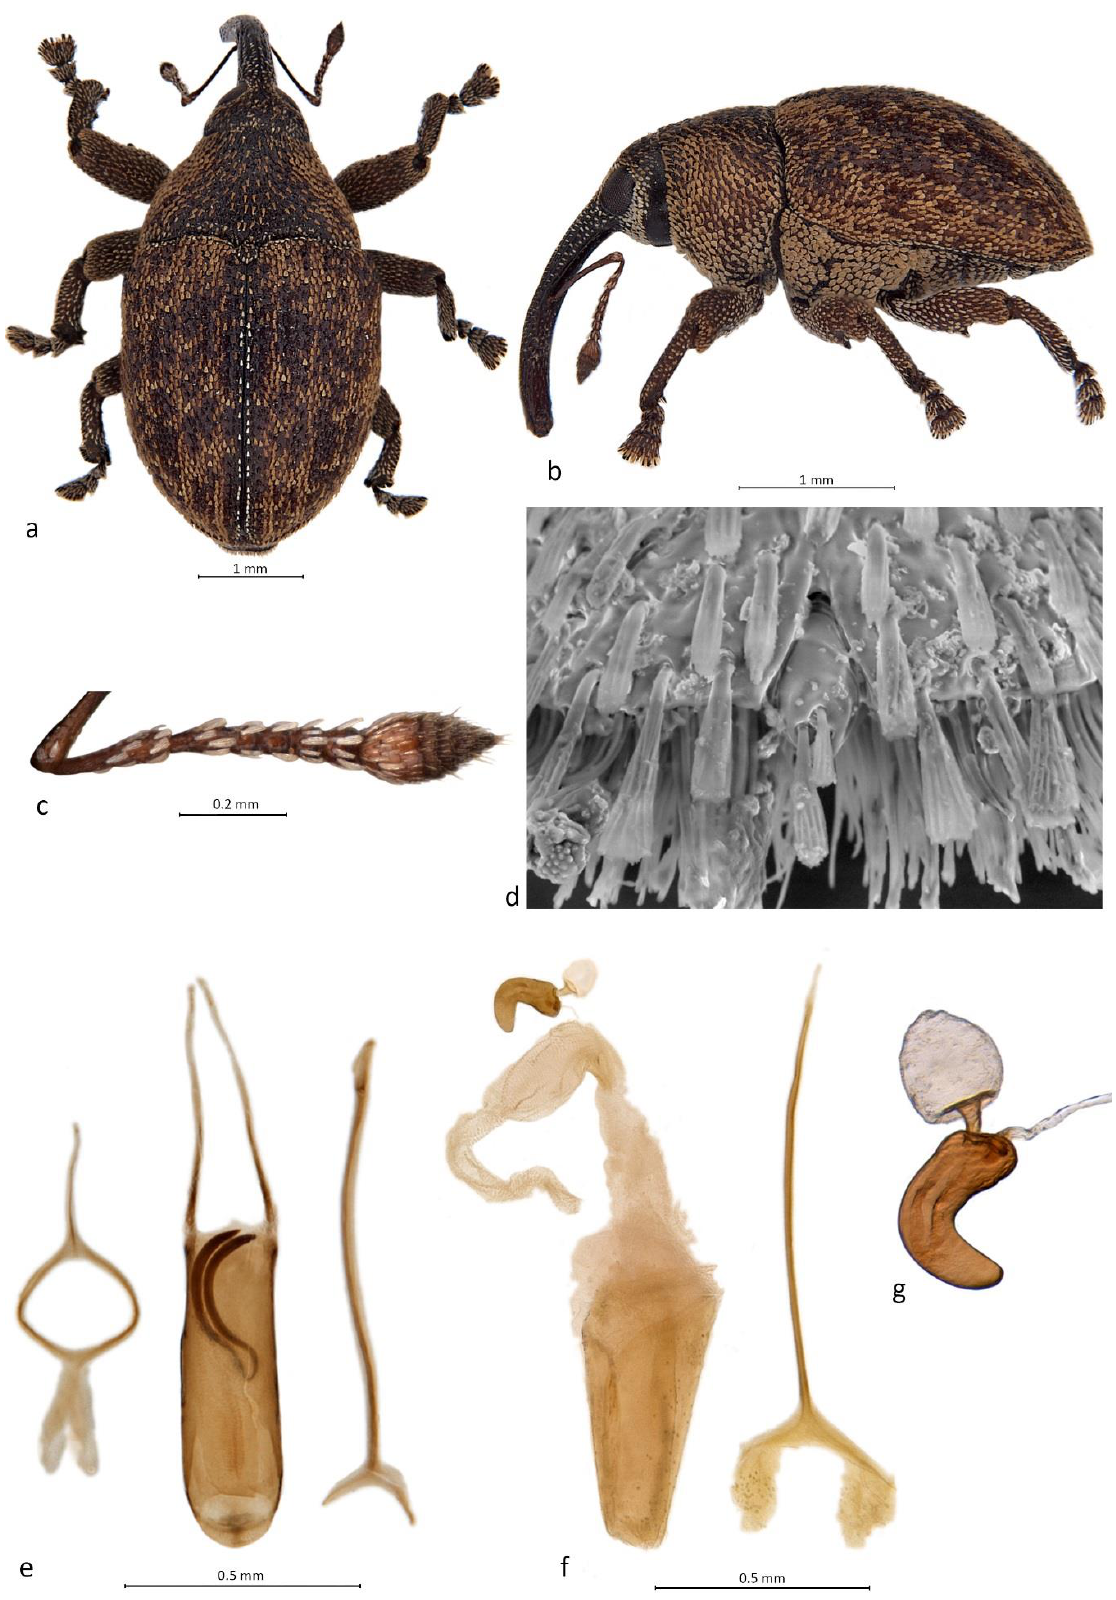
Figure 5. Habitus and diagnostic characters of Zeopus Pascoe ( Z. storeoides Pascoe): ( a ) habitus of male, dorsal view; ( b ) habitus of male, left lateral view; ( c ) right antenna, male, dorsal view; ( d ) tarsite 3 with onychium, apical view; ( e ) genitalia, male, dorsal view; ( f ) genitalia, female, dorsal view; ( g ) spermatheca with gland.